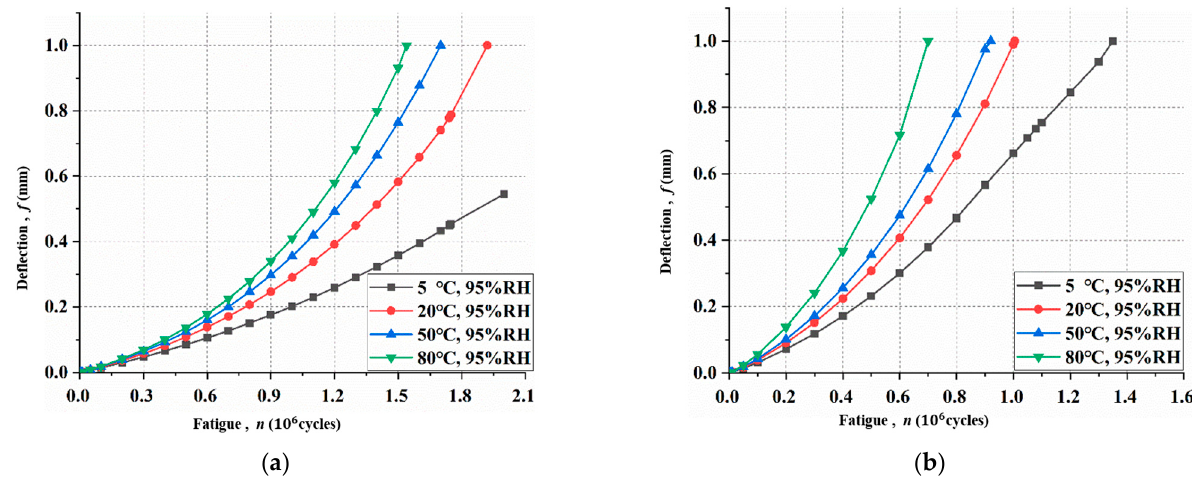
Figure 6. Cumulative damage of rebar under different hygrothermal environments at different loading levels: ( a ) 27.5 kN; ( b ) 30.0 kN.